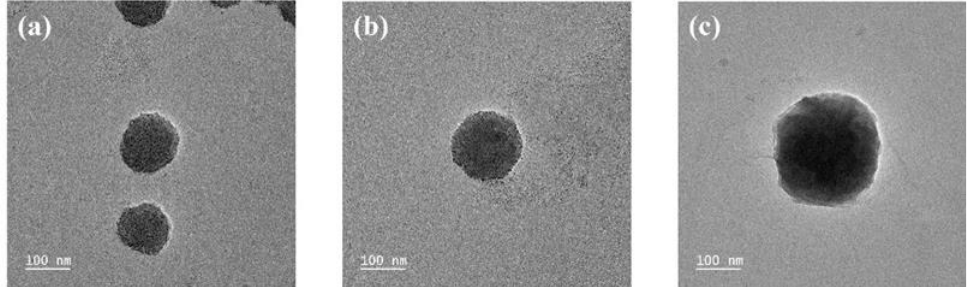
Figure 1. Representative transmission electron microscopy (TEM) images of RES-UA NPs at pH values of ( a ) 7.4, ( b ) 6.0, and ( c ) 5.0.